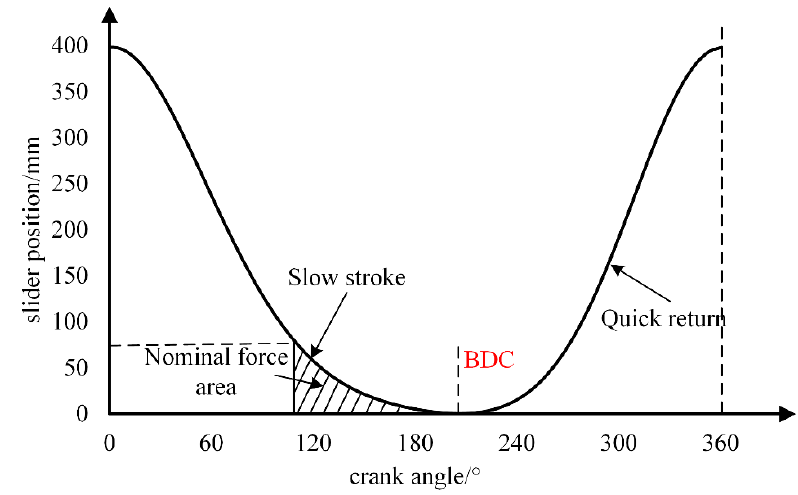
Figure 3. Diagram of slider displacement curve.